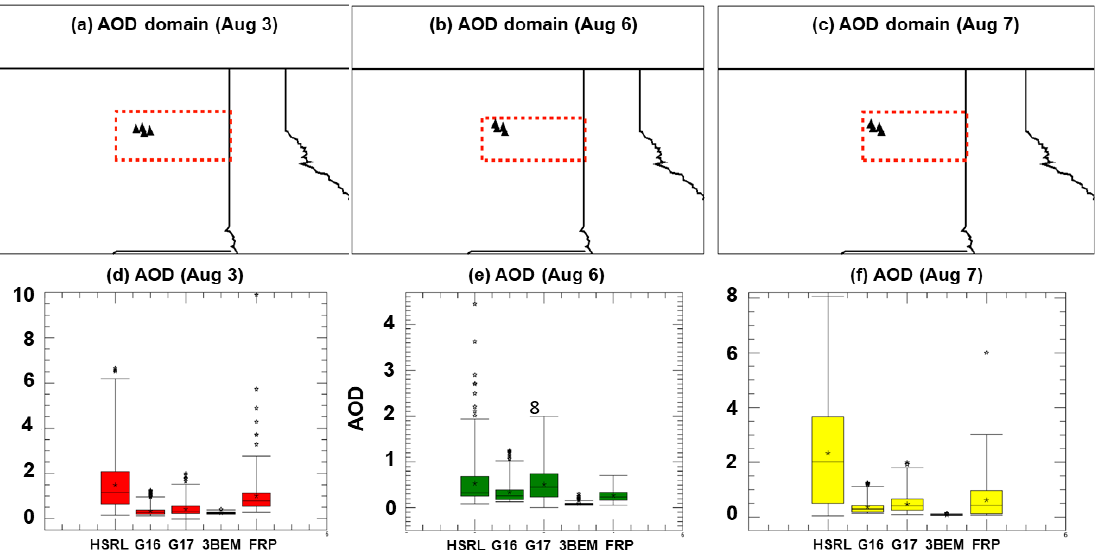
Figure 8. AOD estimates for HSRL, GOES-16/17, and WRF-Chem (3BEM and FRP versions) for the 3 August (d) , 6 August (e) , and 7 August (f) DC-8 science flights. The domain over which the AODs are being compared is also shown (a–c) . Each box plot represents the minimum value, lower quartile, median, upper quartile, and maximum value. The mean is represented as the asterisk ( ∗ ) symbol in the bar, and the outliers are represented by the star